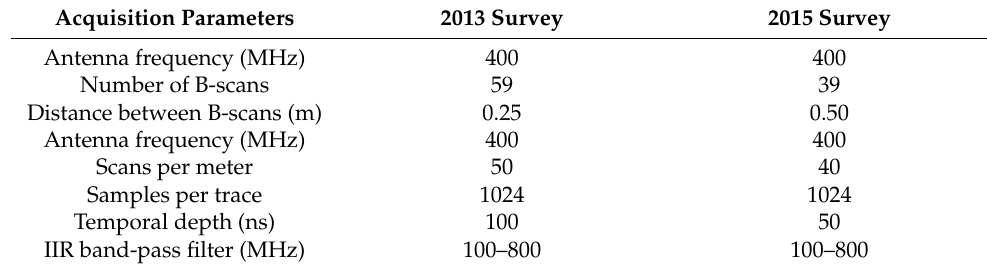
Table 1. Acquisition parameters of GPR